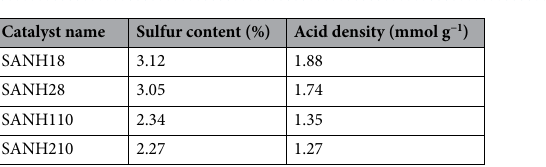
Figure 1. Direct sulfonation of biomass to insert sulfonic active sites.